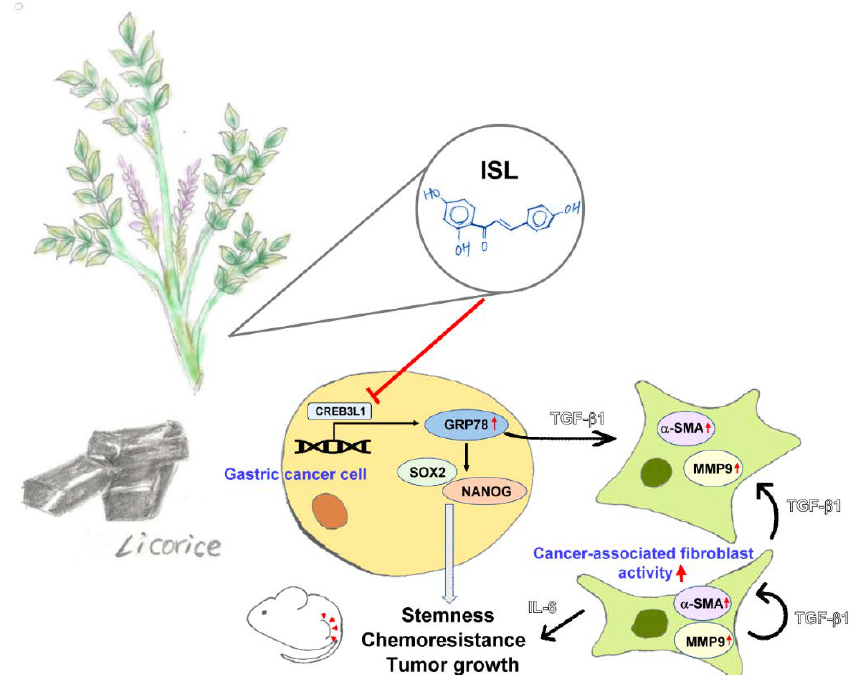
Figure 10. Graphical scheme depicting that isoliquiritigenin (ISL) inhibited gastric cancer stemness and tumor growth and regulated the tumor microenvironment by downregulating GRP78.